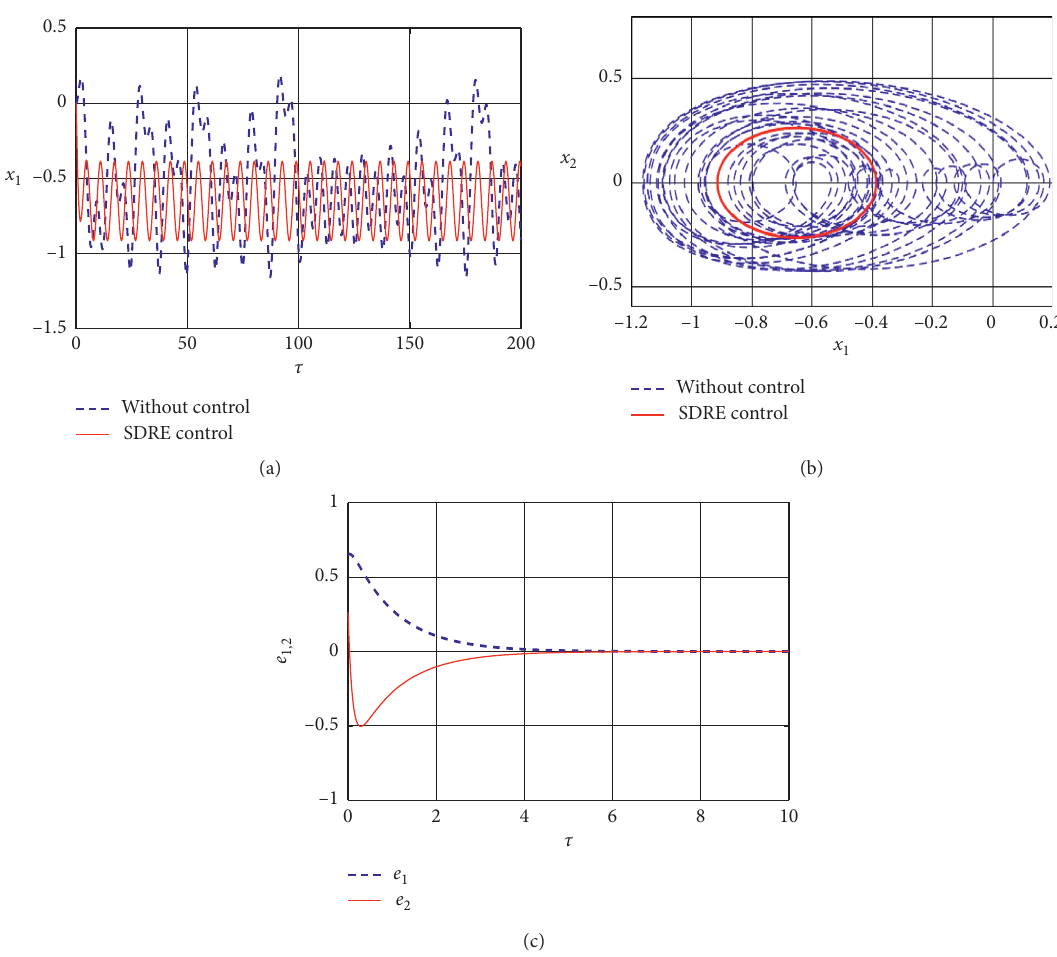
Figure 9: (a) Displacement of the tip with control (solid line) and without control (dashed line); (b) phase portrait of the tip with control (solid line) and without control (dashed line); (c) error variation e